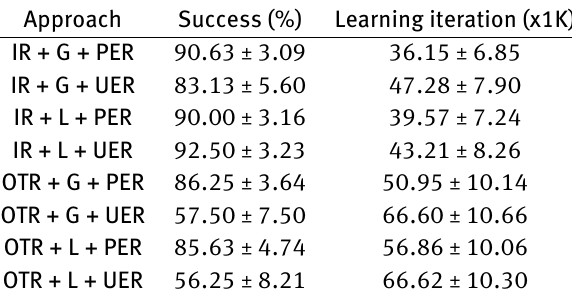
Table 5: Performance of the agent during the first 150K iterations. UER= Uniform Experience Replay, PER = Prioritized Experience Re- play, IR= Intermediate Reward, OTR= Only Terminal Reward, G= Global and L= Local Estimation of the state value. Each row repre- sents 160 experiments (16 RL agents × 10